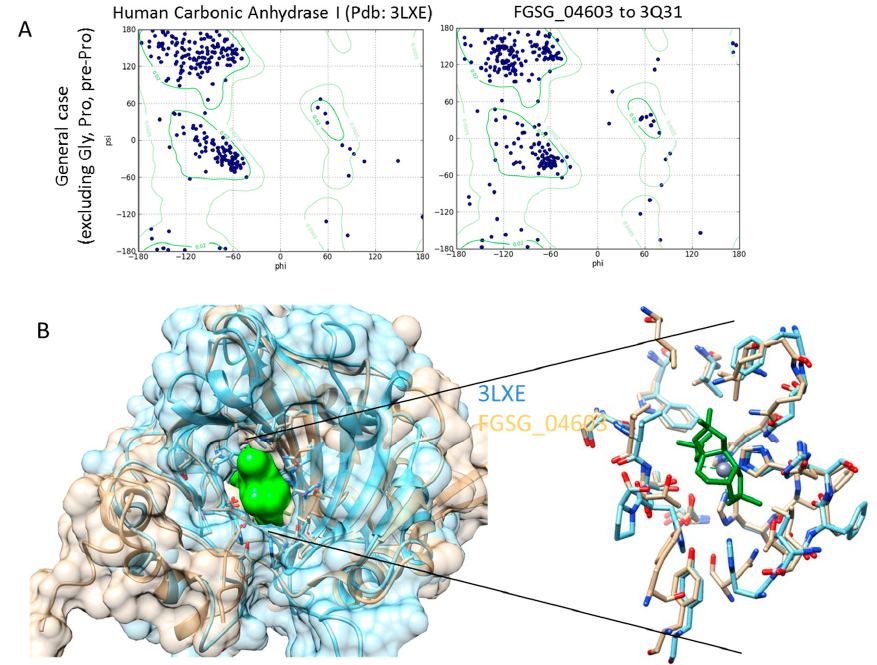
Figure 4. Model of Fusarium graminearum CA (FGSG_04603) in comparison to human CA. ( A ) Ramachadran plots showing protein backbone dihedral angles for amino acids. Dots present the angles (psi vs. phi) and outlined are energetically preferred angles. Shown are values for measured and calculated protein structures for human CA1 (measured) and fungus (calculated); and ( B ) comparison of structures of human and fungal CAI binding regions with inhibitory molecules included in green.